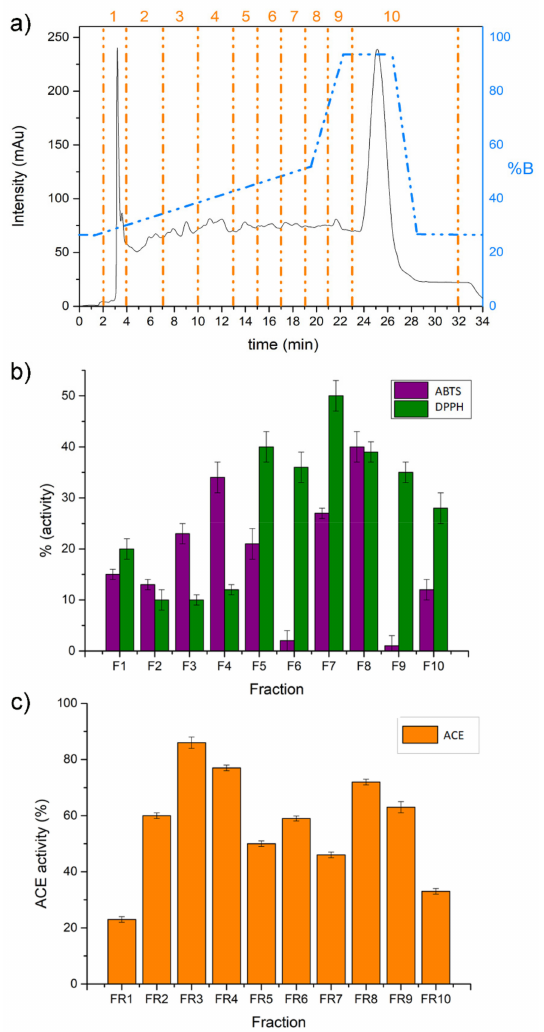
Figure 1. ( a ) Semi-preparative reverse phase high-performance liquid chromatography profile of Alcalase ® hydrolysate of asparagus by-product. Fractions (F1–F10) are indicated by vertical dashed lines. The dotted line represents the gradient of solvent B. Bar chart displaying the results of antioxidant (ABTS and DPPH) ( b ) and ACE-inhibitory activity assays on collected fractions ( c